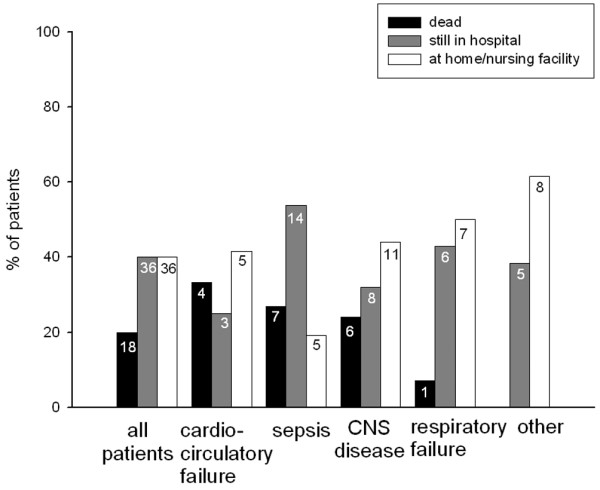
Patient outcome in all patients and in the different patient groups. The numbers in the bars indicate the absolute number of patients per subgroup. Eight patients were lost to follow-up and had to be excluded from outcome analysis. No statistical difference was found for patient location at 28 days in the whole collective and in the different patient groups. CNS, central nervous system.